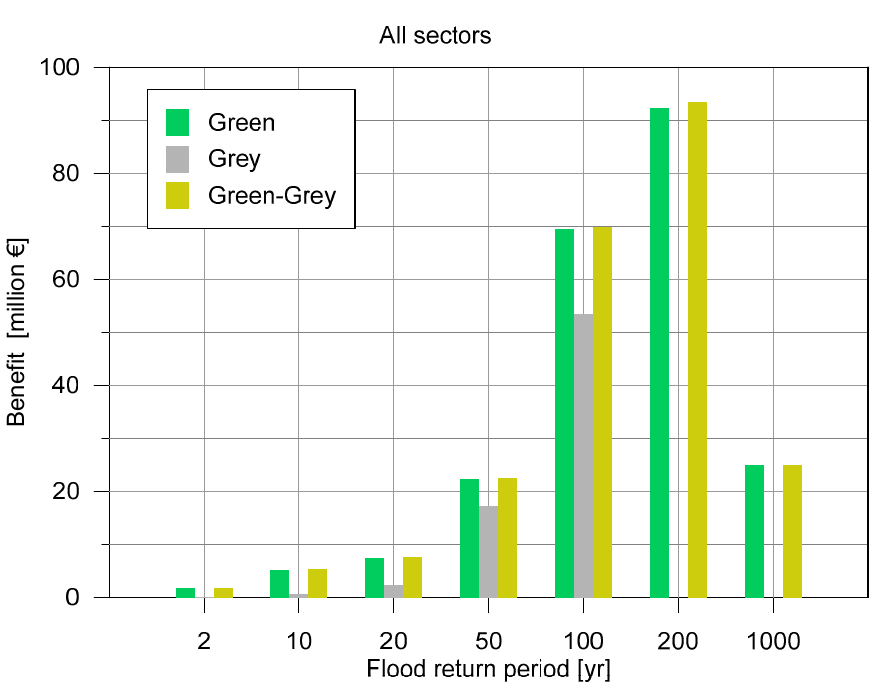
Figure 11. Benefits (loss reduction relative to baseline scenario) in the Tamnava watershed under the three proposed flood mitigation scenarios depending on the flood return period.